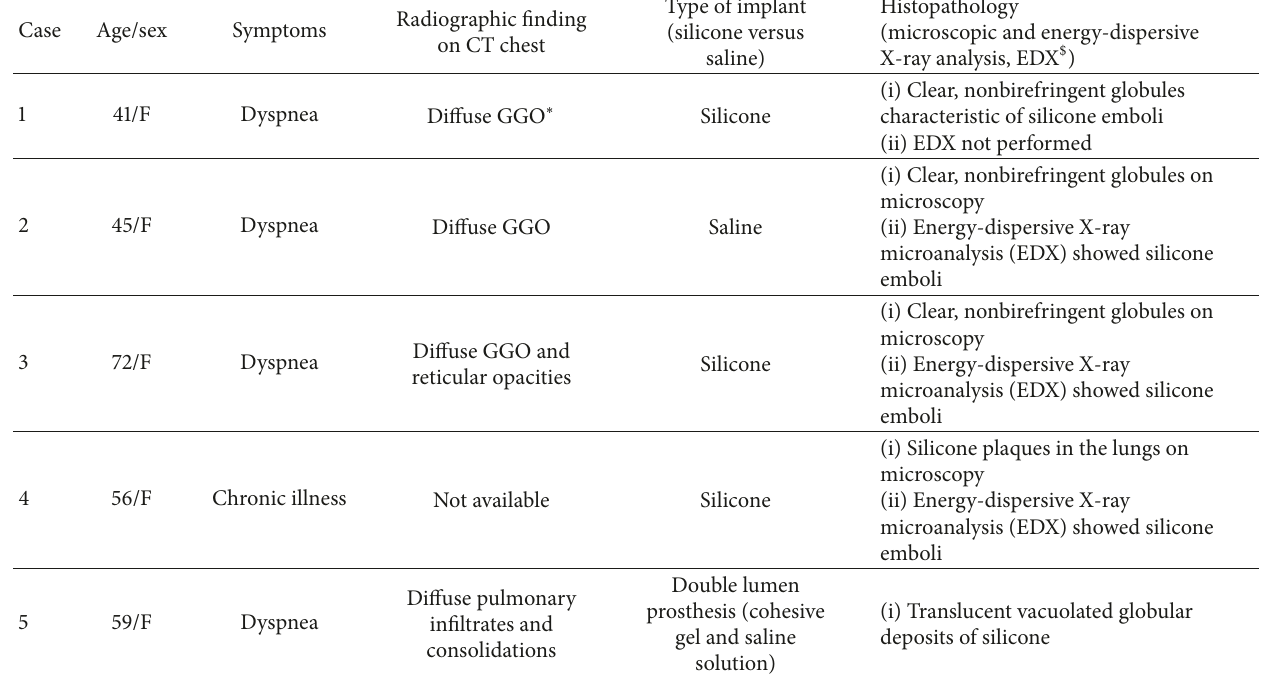
Table 1: Reported cases of chronic pulmonary silicone embolism from the breast